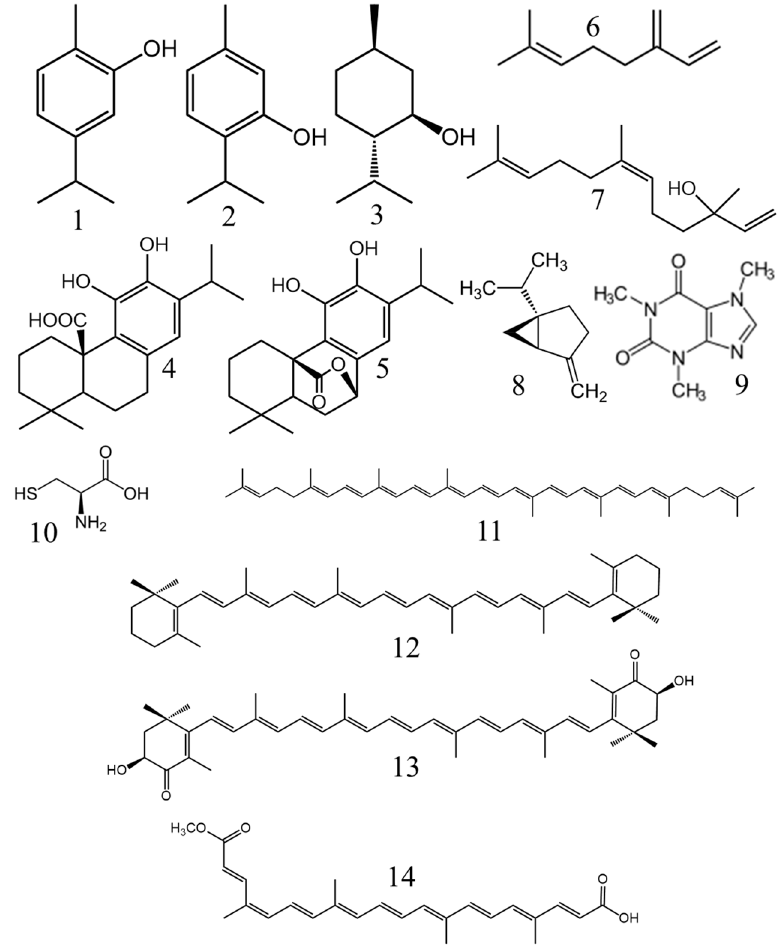
Figure 2. Chemical structures of plant terpenoid (including carotenoids) and nitrogen-containing antioxidants. 1 : carvacrol, 2 : thymol, 3 : menthol, 4 : carnosic acid, 5 : carnosol, 6 : myrcene, 7 : nerolidol, 8 : sabinene hydrate, 9 : caffeine, 10 : L-cysteine, 11 : lycopene, 12 : β -carotene, 13 : astaxanthin, 14 : bixin.